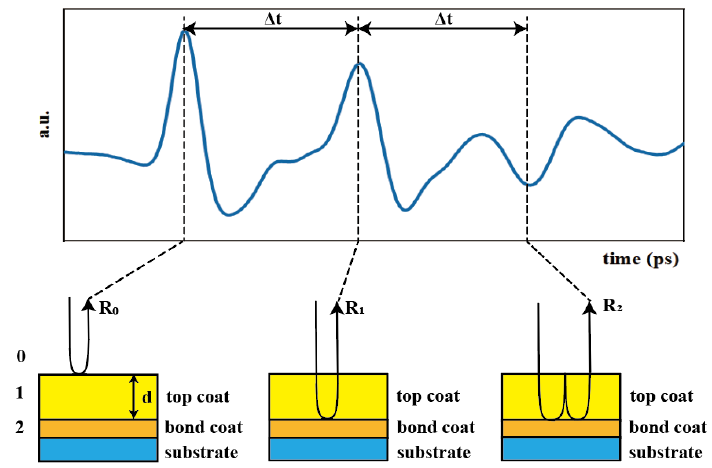
Figure 2. Schematic diagram of the THz propagation path in a sample.